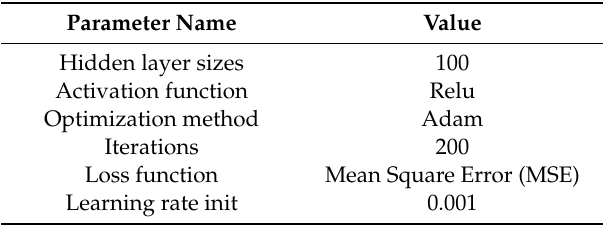
Table 8. Parameters setting of MLPR